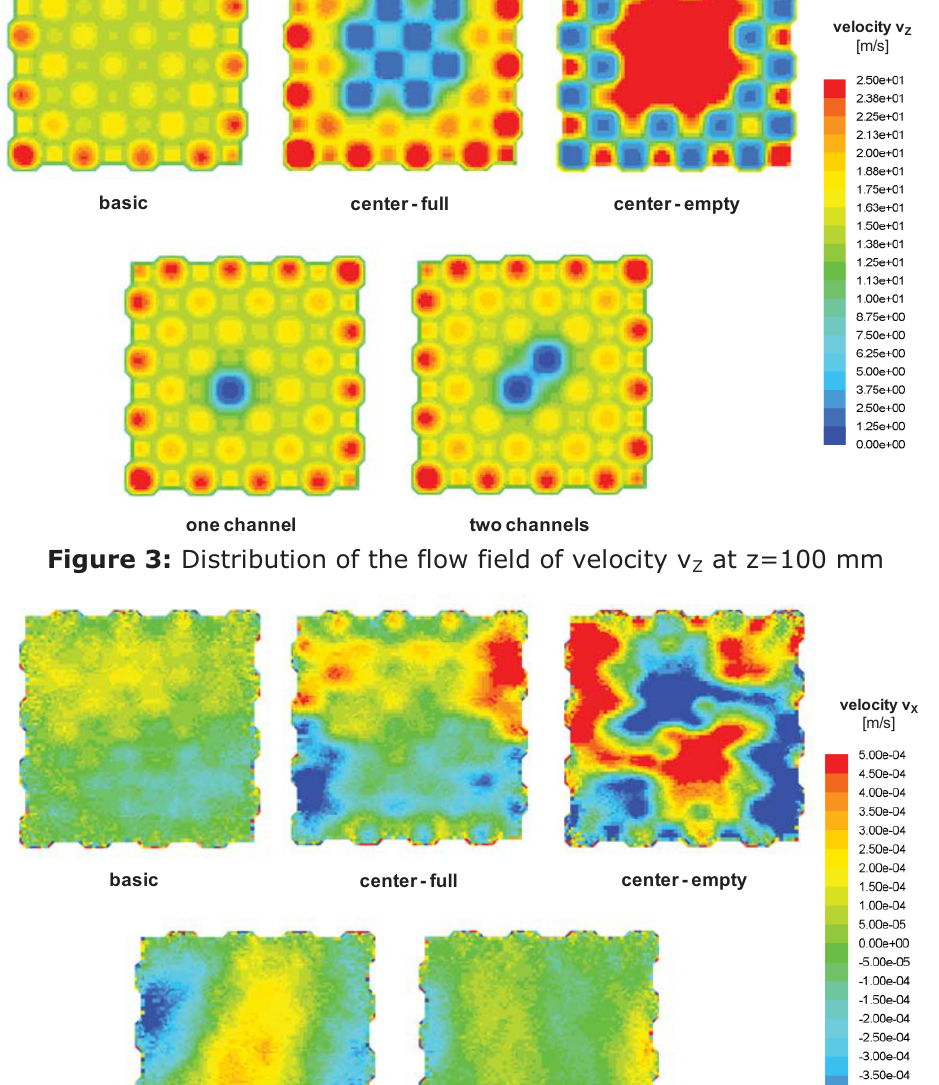
Figure 4: Distribution of the flow field of velocity v